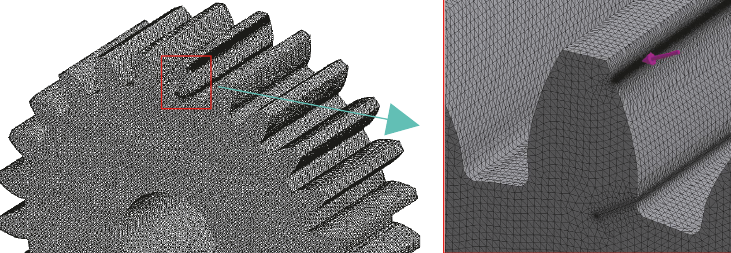
Figure 10: Overall meshing of the pinion and mesh control at the area where the force was applied and the crack region [17].